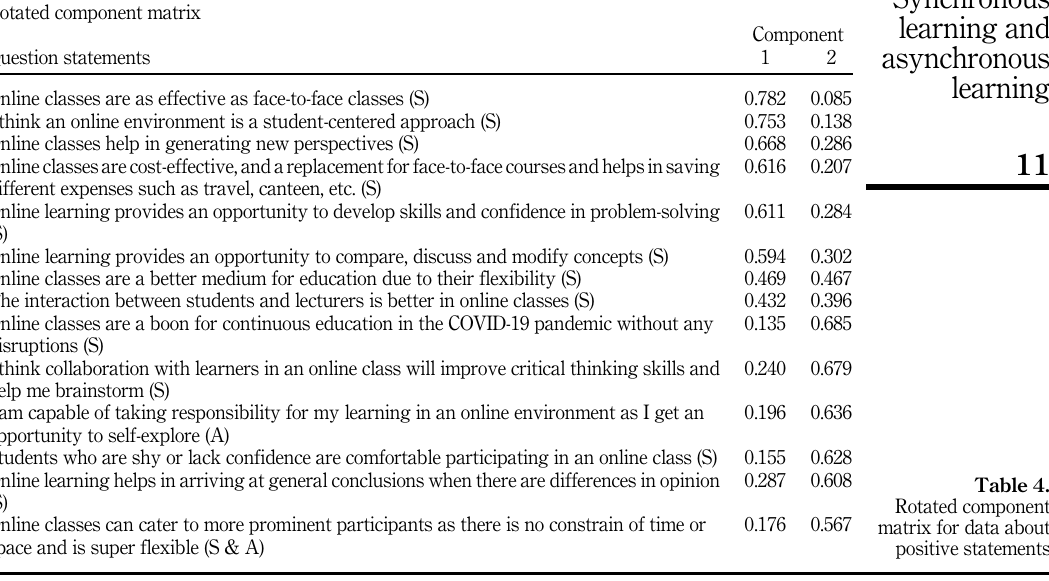
Table 4. Rotated